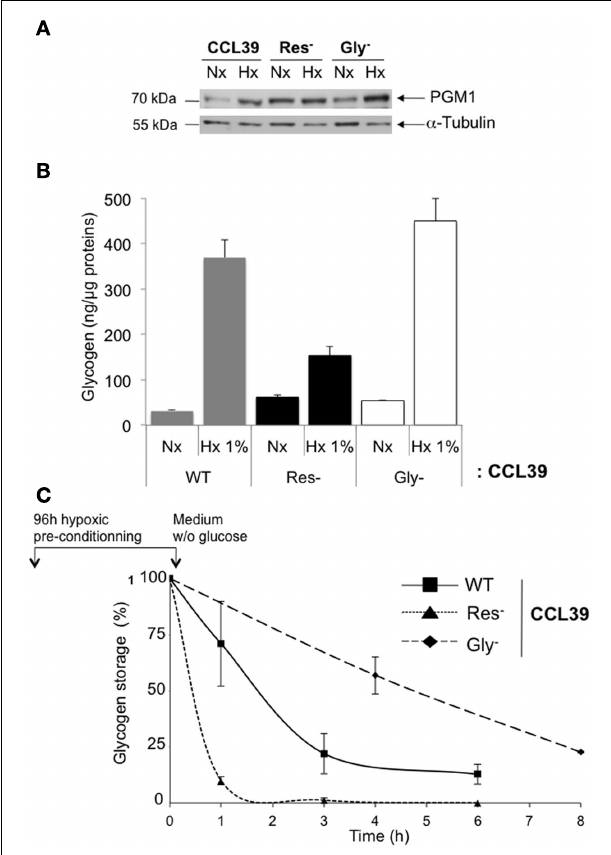
FIGURE 4 | Glycolysis, respiration, and glycogenesis are closely connected. (A) CCL39 wild-type (WT), CCL39 respiratory-deficient (Res − ), and CCL39 glycolysis-deficient (Gly − ) cell lines derived from wild-type CCL39 cells were subjected to normoxia (Nx) and hypoxia 1% O 2 (Hx 1%) for 48h.Total extracts were analyzed by immunoblotting with antibodies against PGM1 and α -tubulin. (B) Quantification of the amount of glycogen inWT (gray bars), Res − (black bars), and Gly − (white bars) cells grown in normoxia (Nx) or hypoxia 1% O 2 (Hx 1%) for 48h. (C) WT ( (cid:2) ), Res − ( (cid:3) ), and Gly − ( (cid:4) ) cells were subjected to hypoxia 1% O 2 for 96h and then cultured in glucose-free medium for up to 8h.The glycogen concentration was measured just before removal of glucose and represents 100%.The results are representative of at least three separate experiments.